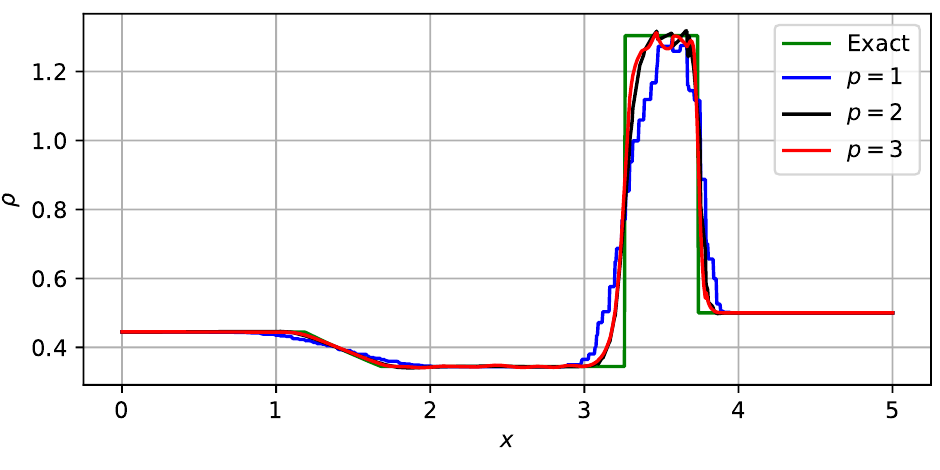
Figure 5. Comparison between solutions of ρ ( t = 0.5 ) in Problem 2.